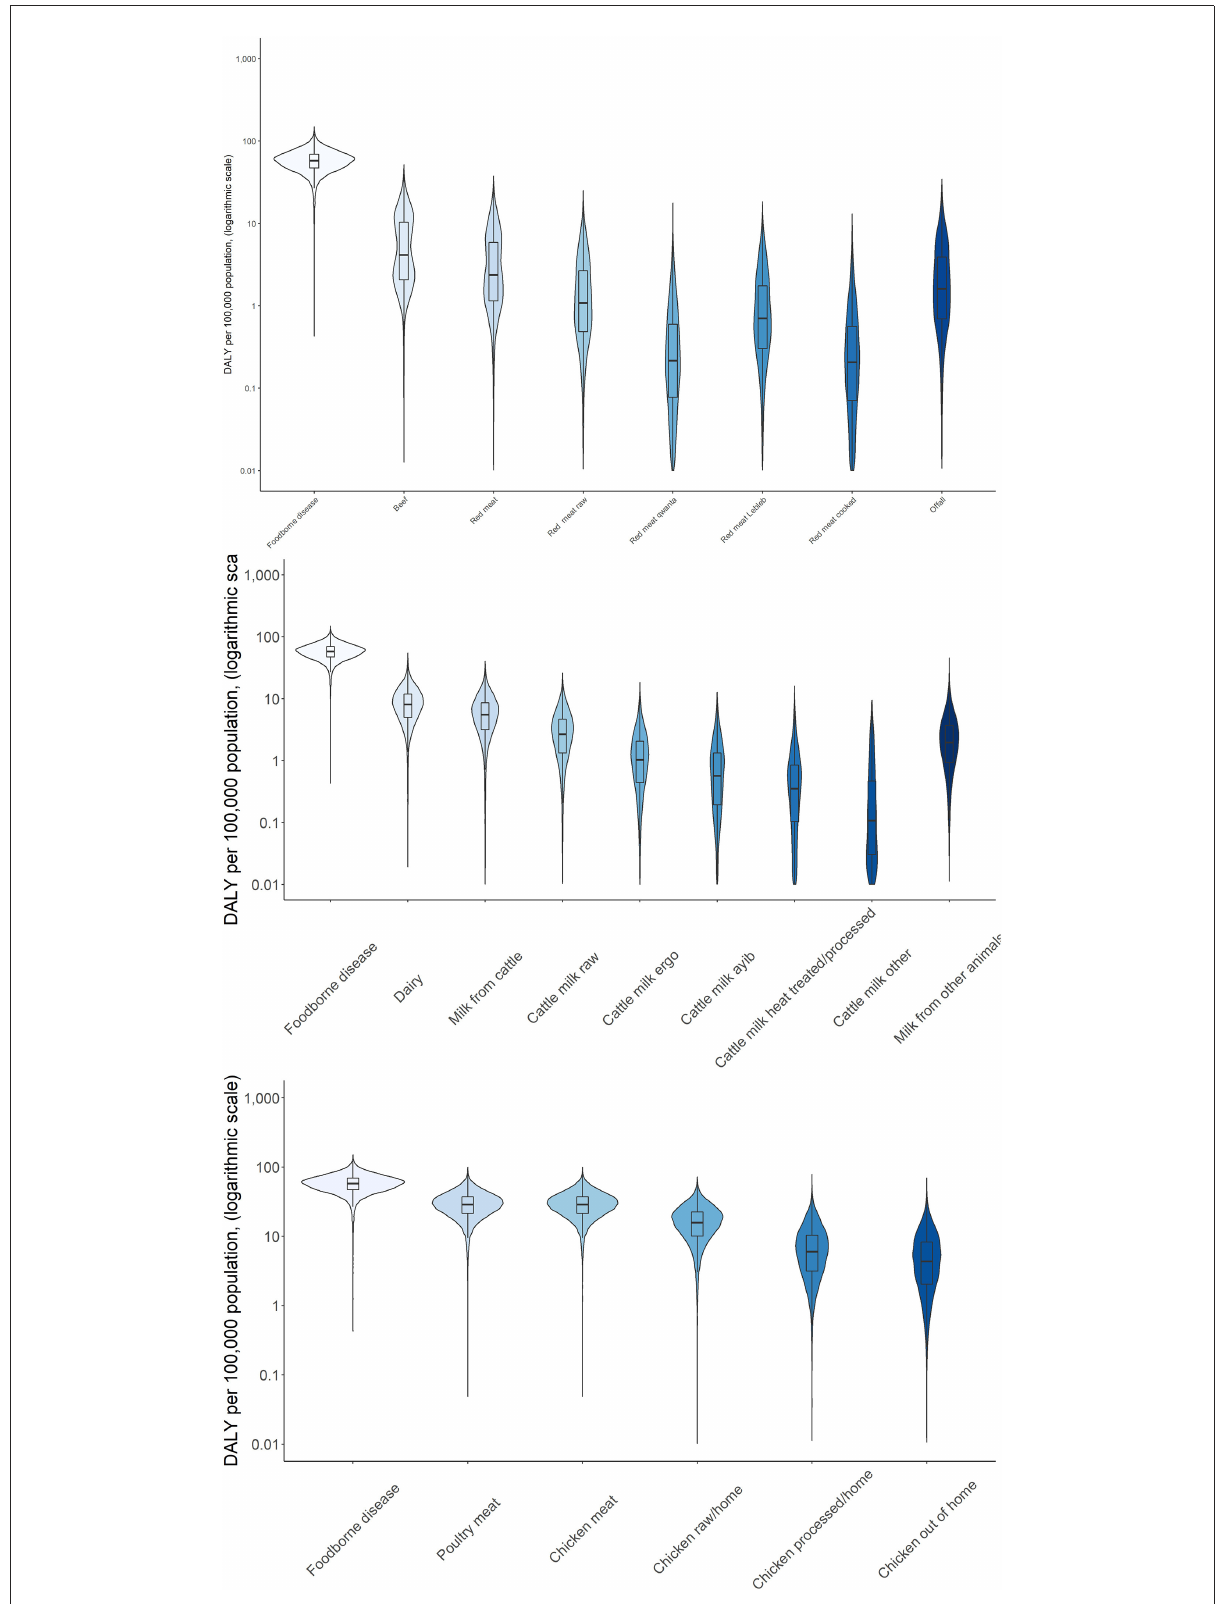
FIGURE6 Attribution of disease burden (Disability-Adjusted Life Years per 100,000 population) of Campylobacter spp. to food types and food products in Burkina Faso in 2017. See Figure 1 for explanation of violin plots.